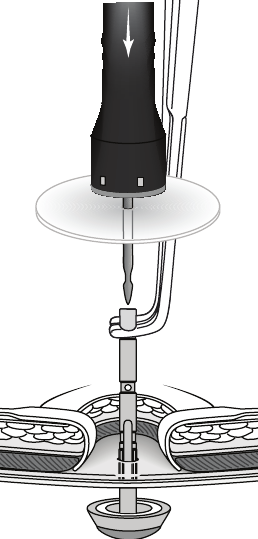
Figure 1: The circular stapler trocar was fitted with a mesh and engaged with the anvil. Reproduced with permission from Norman Williams © [3].